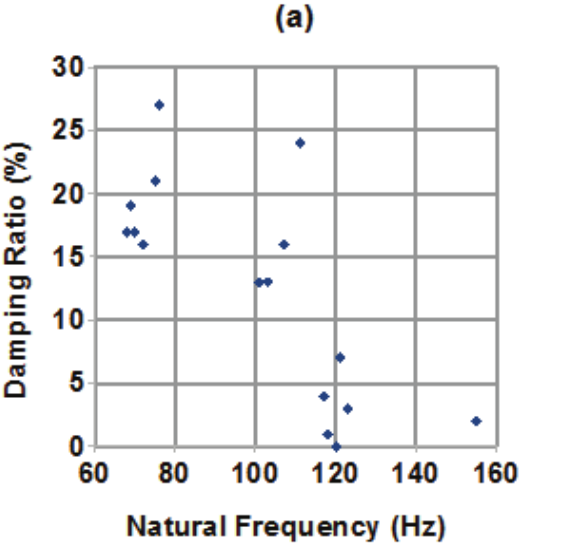
Figure 7. ( a ) Plot of modal damping ratio against natural frequency. ( b ) Plot of MAC relative to behaviour reported in the literature [5] against natural